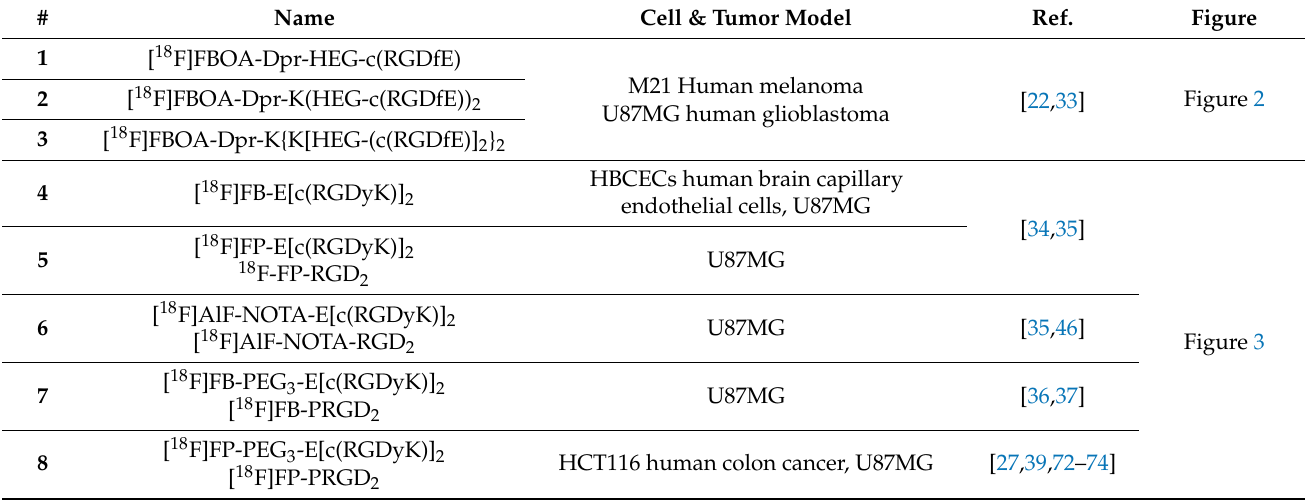
Table 2. List of c(RGD) multimeric radioligands α v β 3 -integrin cell and tumor models tested. Cell & Tumor Model